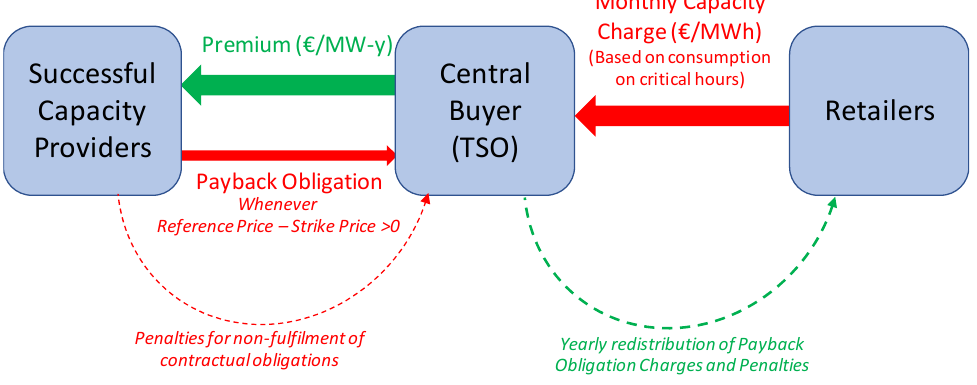
Figure 3. High-level design of the proposed CRM.